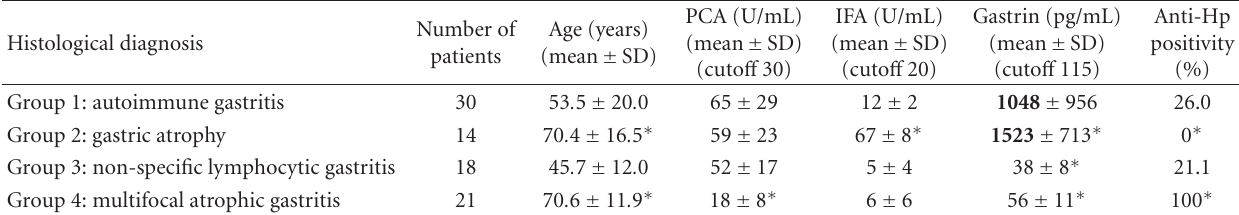
Table 1: Analytic data of the four serological markers in relation to histological diagnosis. Histological